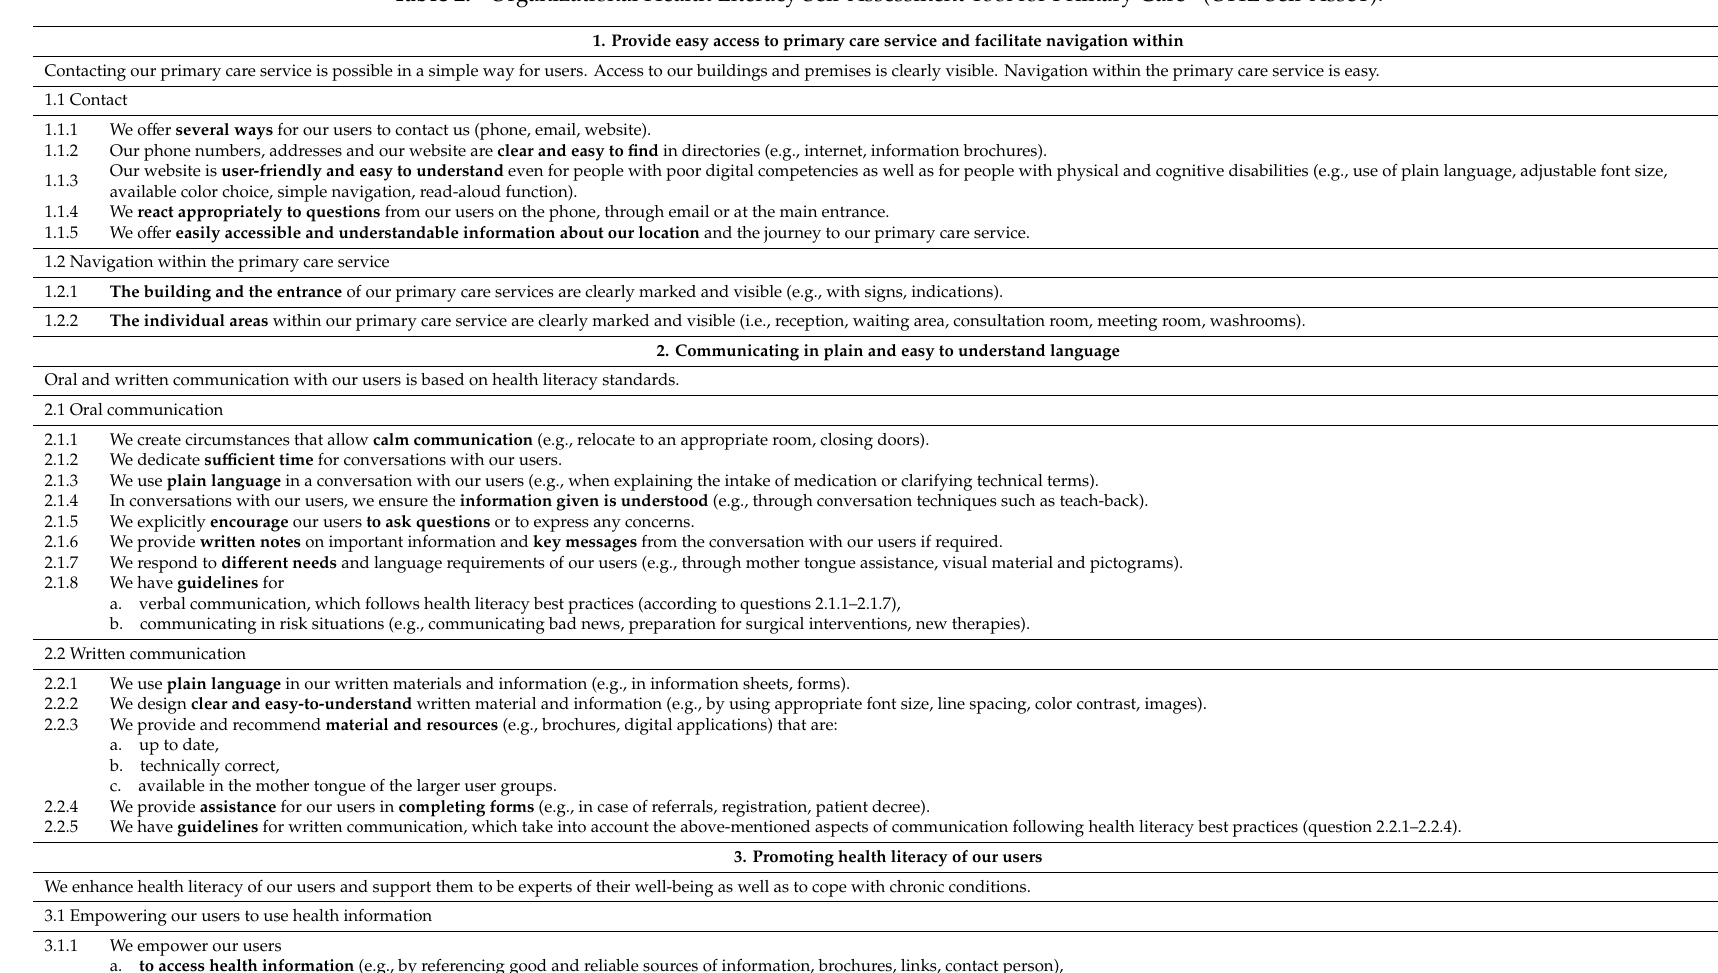
Table 2. “Organizational Health Literacy Self-Assessment Tool for Primary Care” (OHL